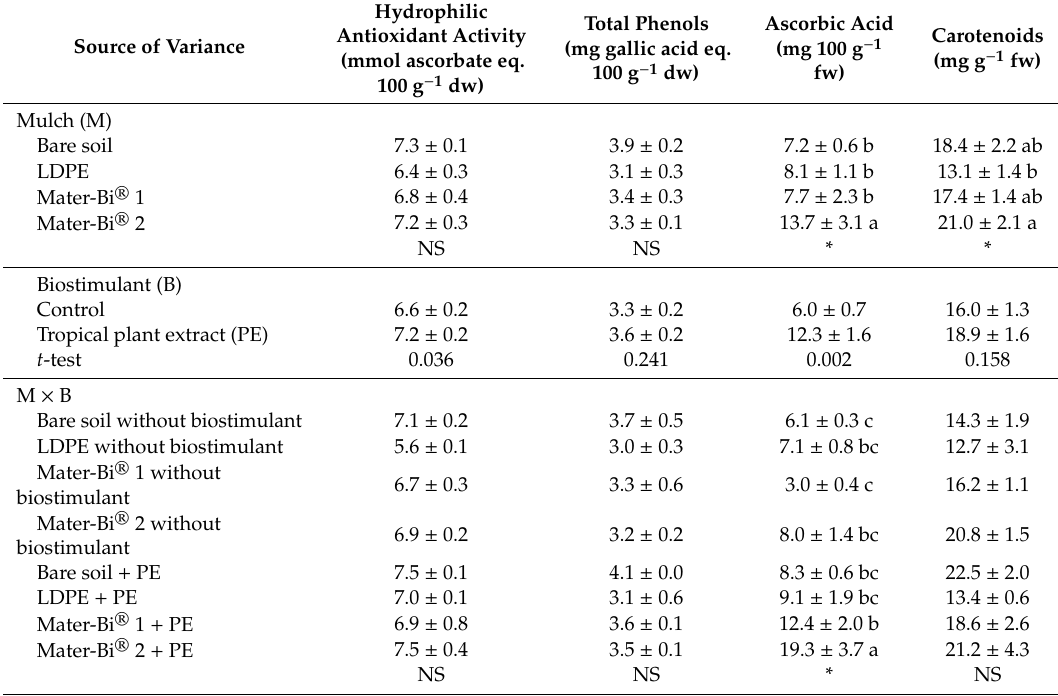
Table 4. Mean comparison and analysis of variance for hydrophilic antioxidant activity, total phenols, total ascorbic acid and carotenoid contents of untreated and biostimulant-treated greenhouse lettuce grown under LDPE mulch and biodegradable (Mater-Bi ® 1 and Mater-Bi ® 2) mulching materials in relation to bare